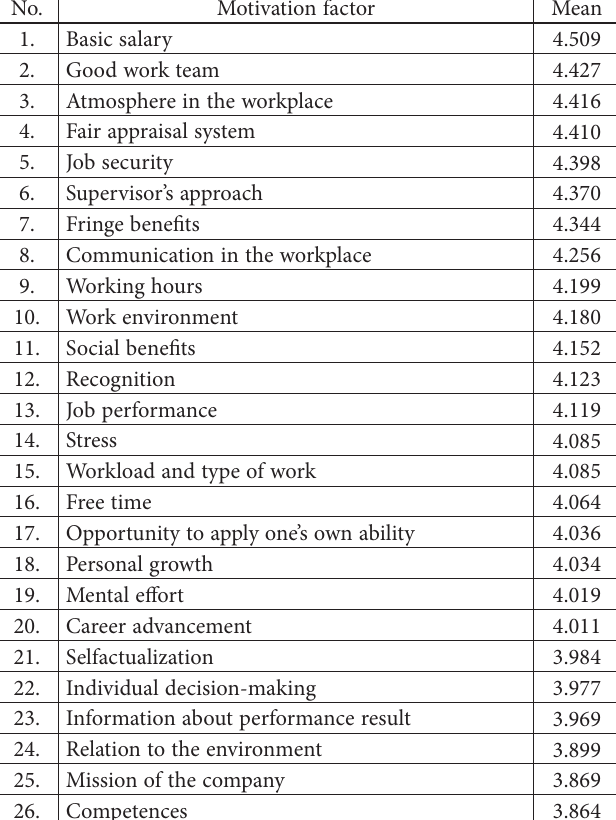
Table 2. Importance of motivation